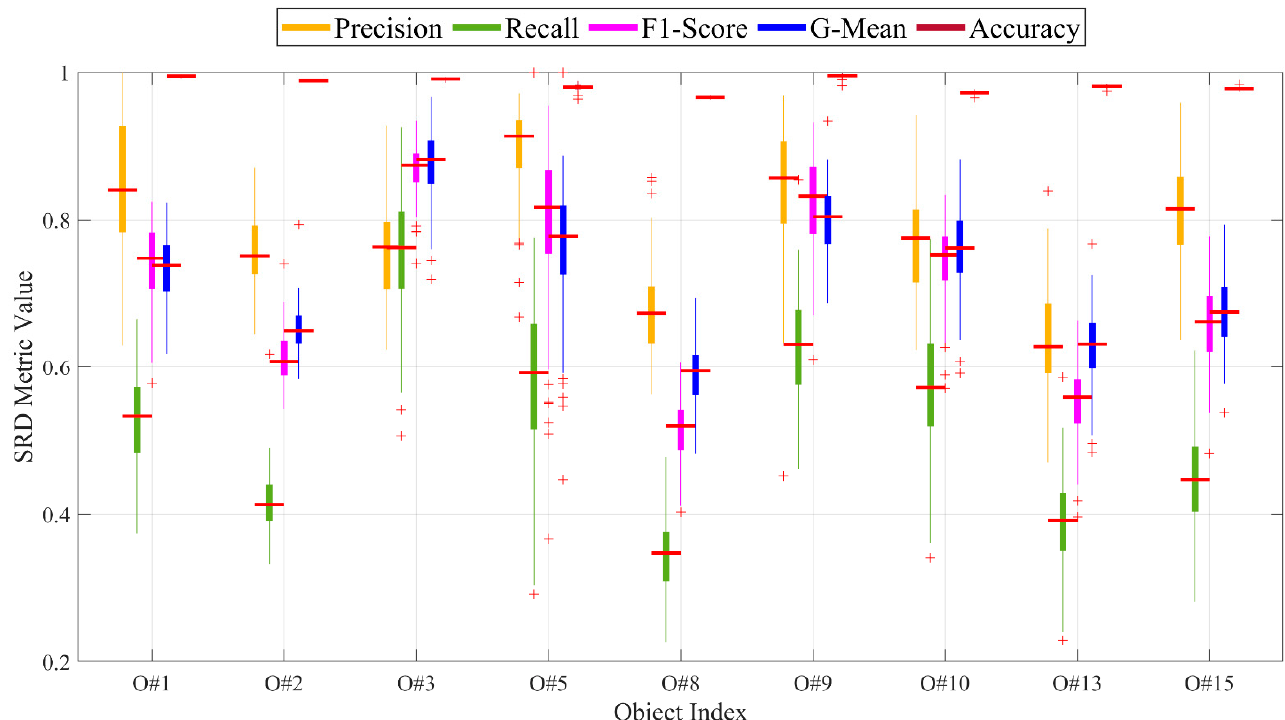
Figure 9. Evaluation results for SRD performances of proposed method for 122 specular reflected images (121 sub-apertures + 1 maximum) of nine sample objects separately using different SRD metrics.